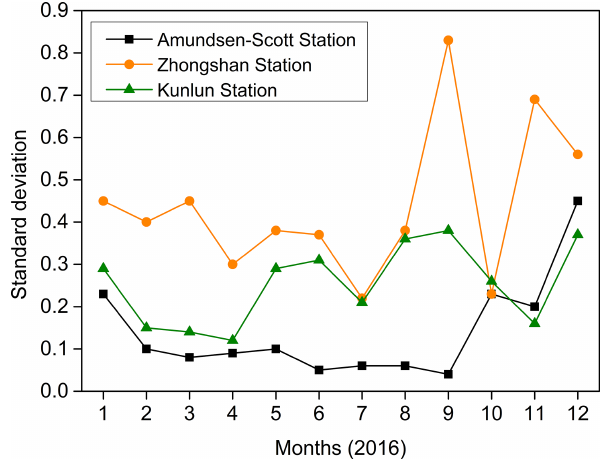
Figure 5. Standard deviations of mean diurnal variation in near- surface O 3 concentrations at SP, DA and ZS during